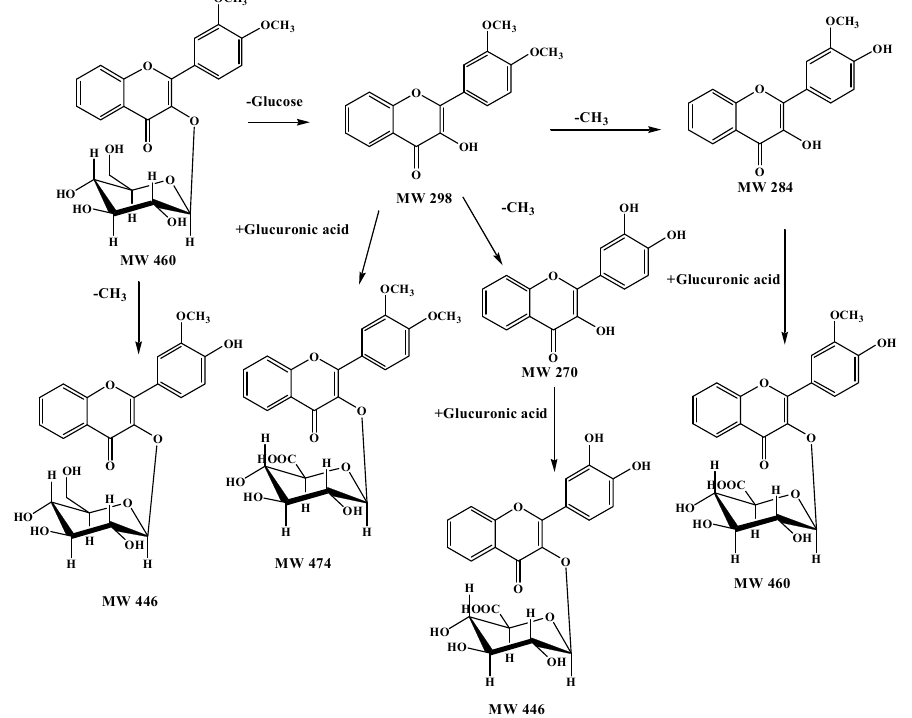
Figure 5. Possible metabolic pathways of DF3G in rats.